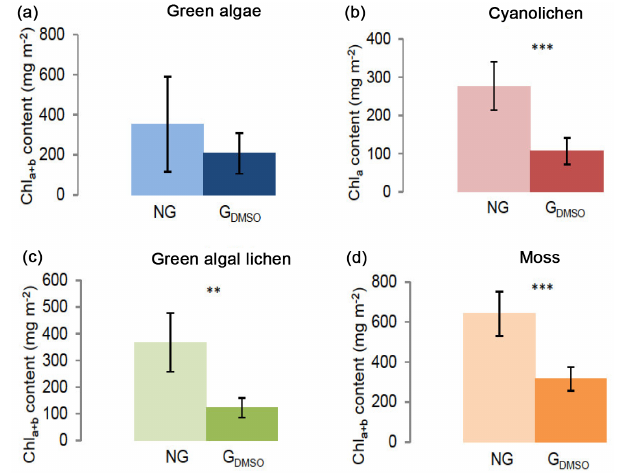
Figure 3. Chlorophyll a + b /chlorophyll a content (mgm − 2 ) de- pending on preparatory grinding in a wet state with DMSO added ( G DMSO ) as compared to control extractions without grinding (NG). Investigation of green algae- (a) , cyanolichen- (b) , green al- gal lichen- (c) , and moss-dominated biocrusts (d) using the DMSO extraction method. To prove statistical differences, an unpaired t test was performed for all four biocrust types ( ∗ p ≤ 0 . 05; ∗∗ p ≤ 0 . 01; ∗∗∗ p ≤ 0 . 001).